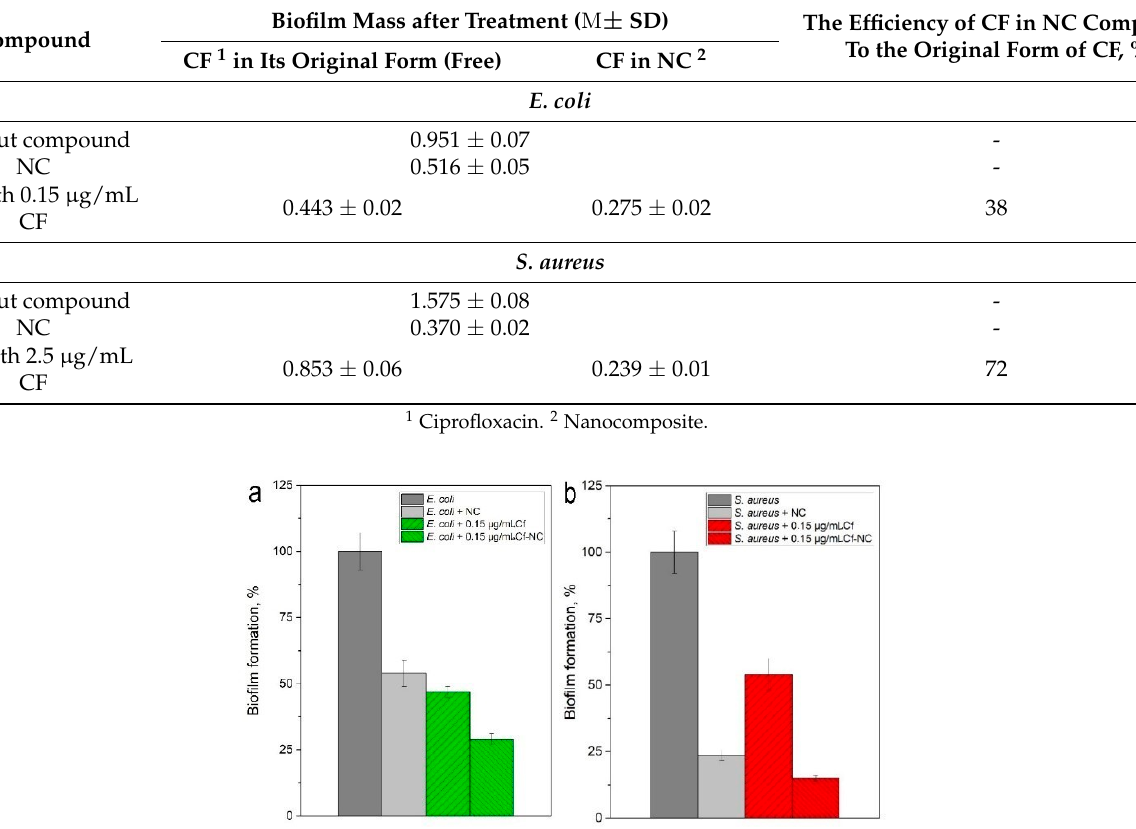
Table 1. Efficacy of nanocomposite against the formed biofilms of E. coli and S. aureus .